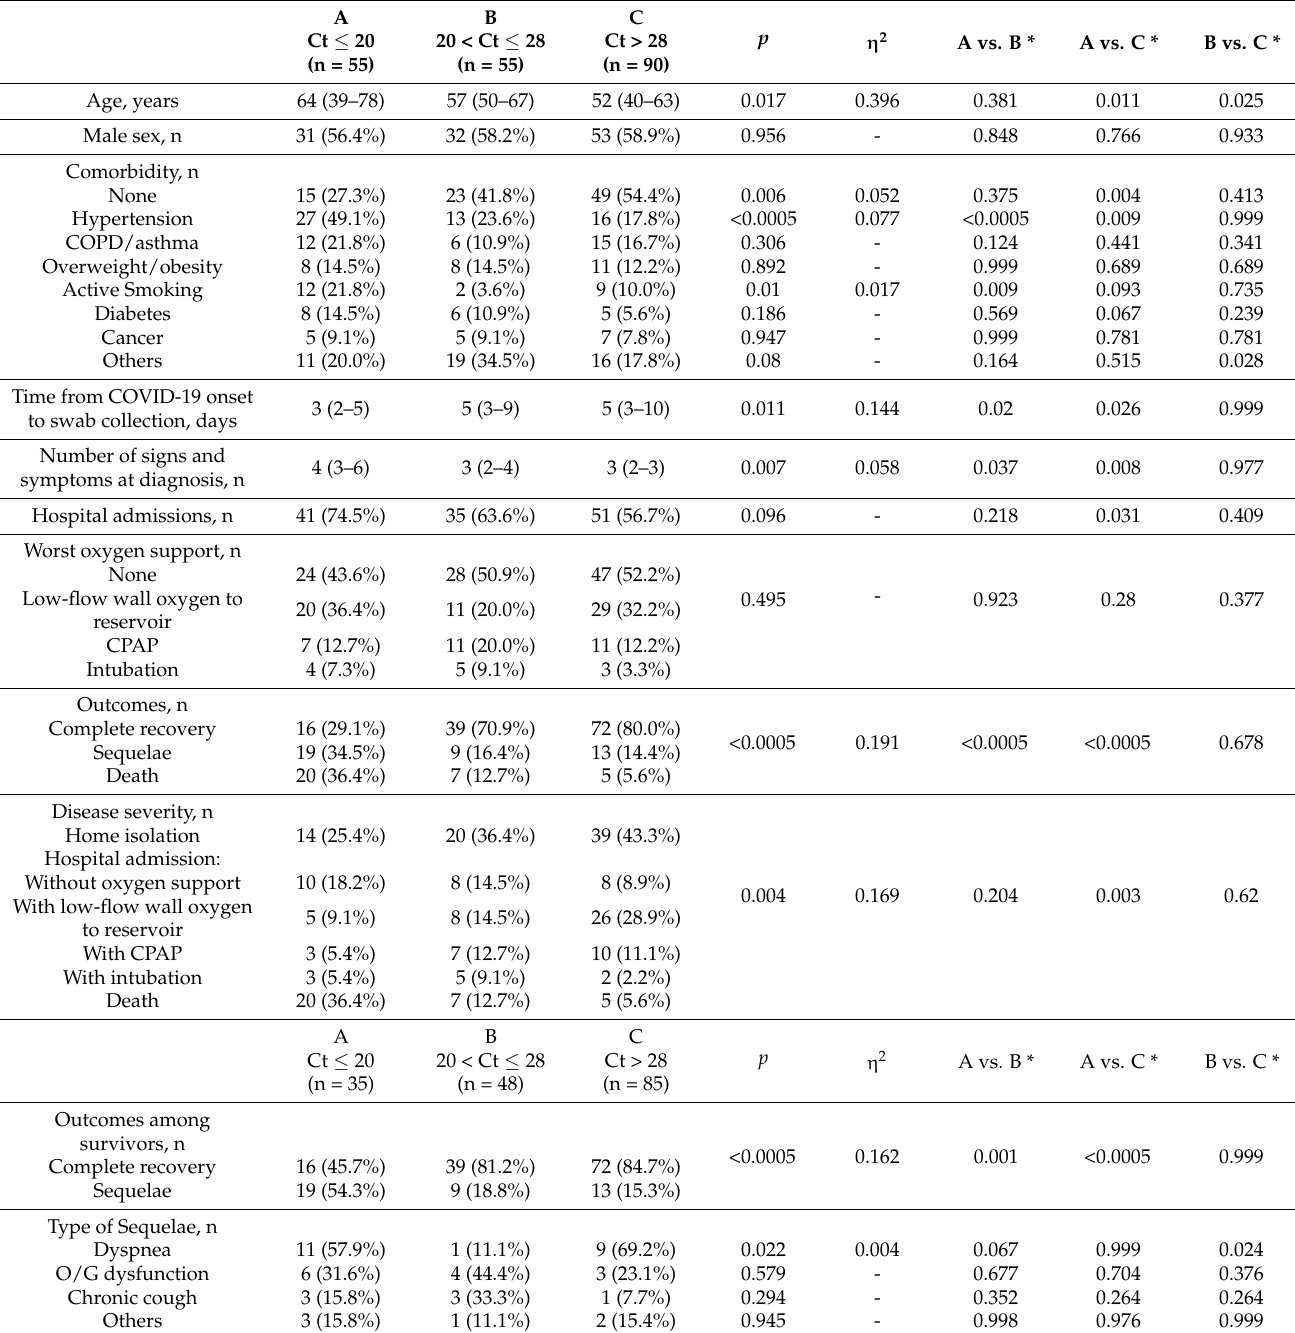
Table 2. Univariate analysis, comparisons of demographic and clinical features between diagnostic SARS-CoV-2 Ct